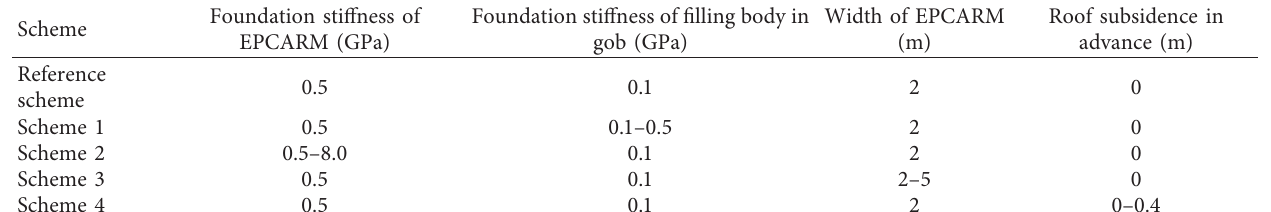
Table 2: Numerical simulation scheme.